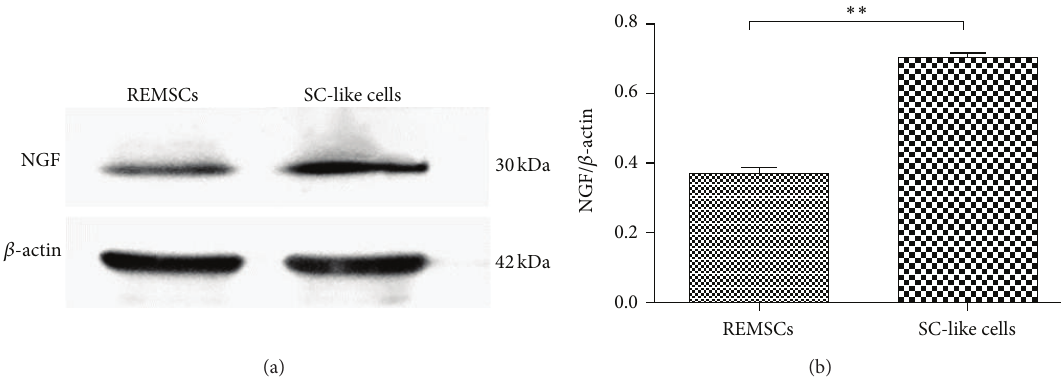
Figure 7: Expression levels of NGF by REMSCs and SC-like cells were observed and quantitated by Western blot. Significant differences between REMSCs and SC-like cells were observed ( ∗∗ 𝑃 < 0.01 ). Data were presented as mean ± SEM from three independent experiments.